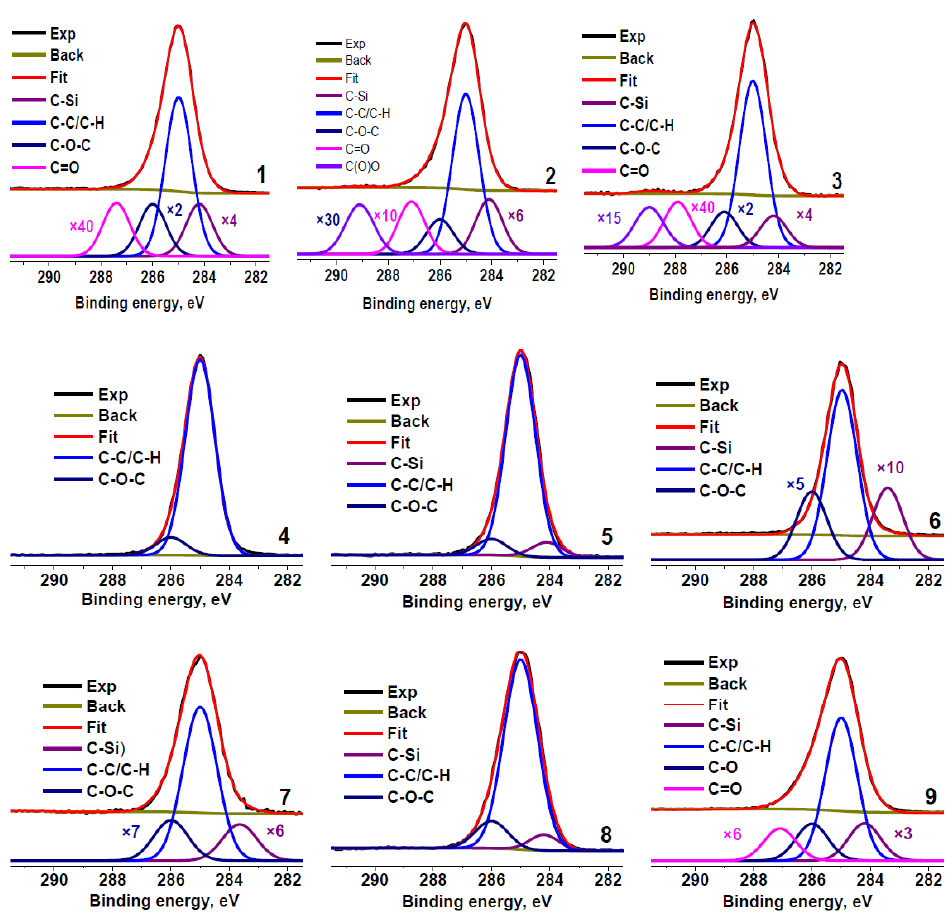
Figure 2. C 1s photoelectron spectra of rubber crumbs, measured in different areas: RC 0-1— a ( 1 ), b ( 2 ), c ( 3 ); RC 1-3— a ( 4 ), b ( 5 ), c ( 6 ); RC 3-5— a ( 7 ), b ( 8 ), c ( 9 ). Table 3. Parameters of components in C 1s photoelectron spectra of rubber crumbs: E b —binding energy, W—peak width, and I rel —relative intensity. O/C is oxygen to carbon ratio calculated from XPS